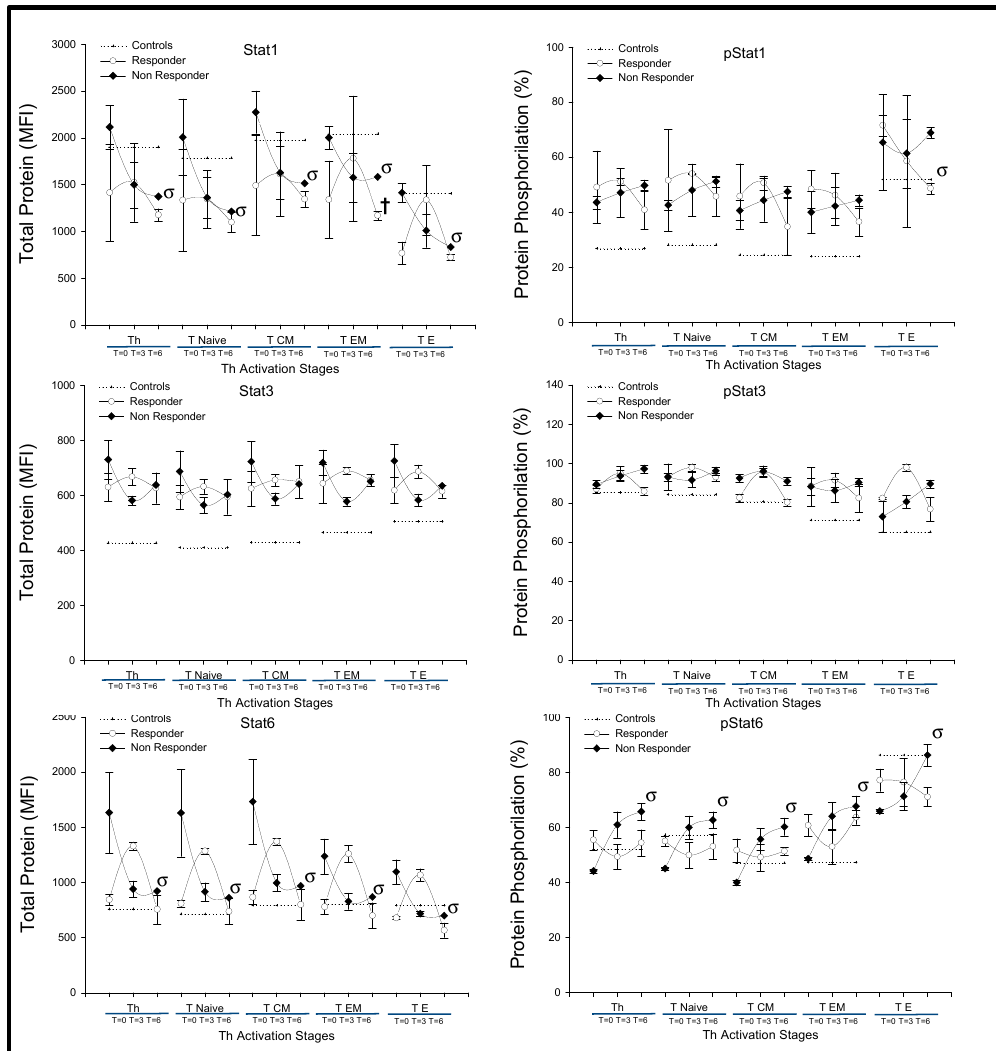
Figure 6. STAT-1, STAT-3 and STAT-6 phosphorylation in CD4 + T-lymphocytes of RA patients according to MTX response. Note: Data represent the mean florescence intensity (MFI) and percentage (%) of total and phosphorylated proteins, respectively, on CD3 + CD4 + , T Naïve , T CM , T EM , and T E CD4 + T-lymphocytes according to the MTX response in ( ) responder and ( ) nonresponder RA patients. The dotted line represents the mean value recorded in healthy controls ( ). All values are expressed as the mean cell numbers ± S.E.M. †, p < 0.05 for responders vs. nonresponders, σ p < 0.05 for 6 months of follow-up time vs. baseline.